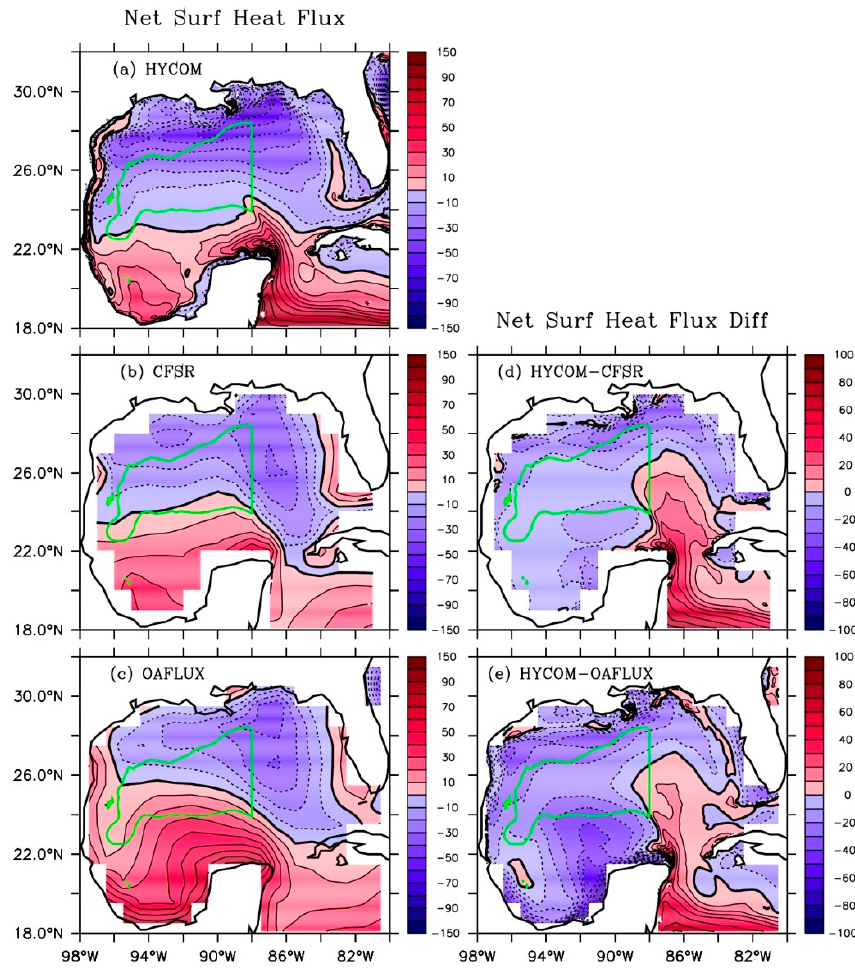
Figure 3. Horizontal structure of mean net surface heat fluxes (in W m − 2 ) in the GOM from ( a ) HY- COM, ( b ) CFSR, ( c ) OAFlux, and its differences for ( d ) HYCOM–CFSR and ( e ) HYCOM–OAFlux. Positive values (i.e., solid curves) denote warming the ocean. The primary position of active eddies in the western GOM is delimited by a green curve.